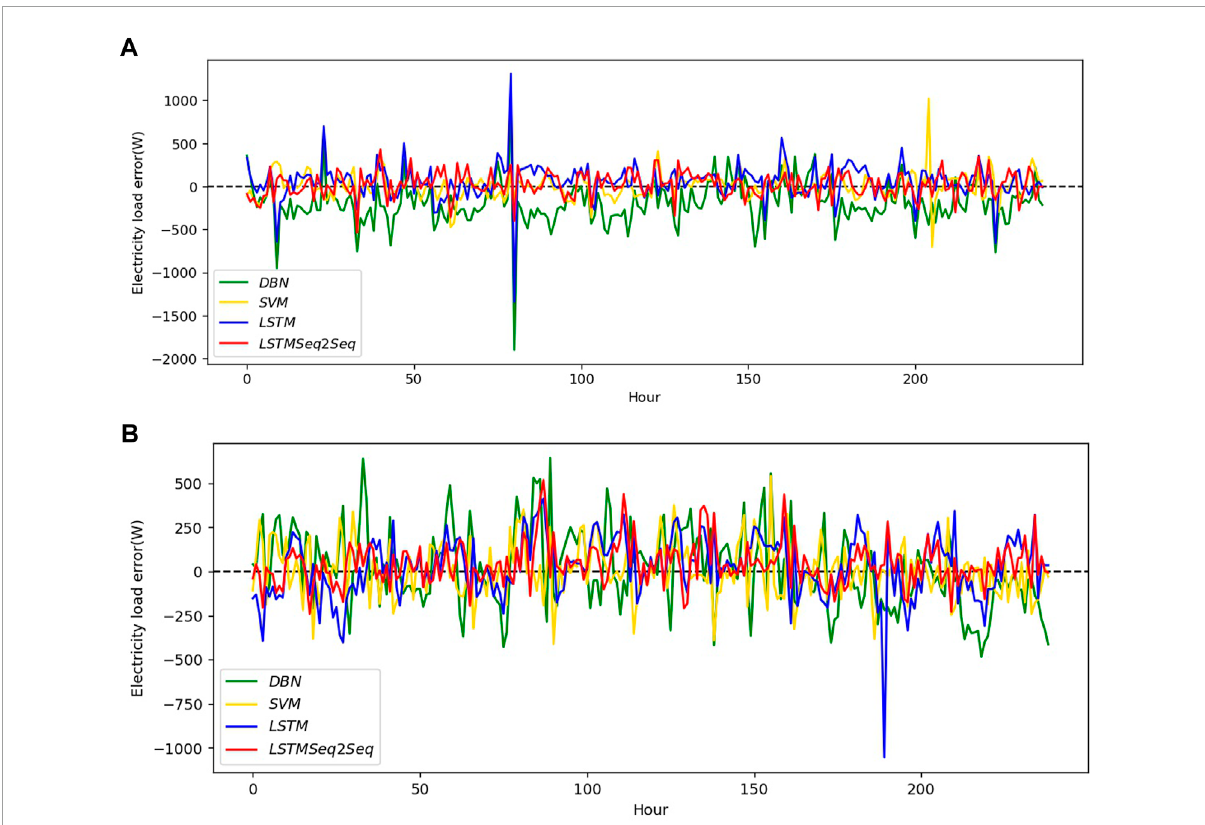
FIGURE 11 Error curves with different models with the two datasets. (A) Error curves with different models with dataset 1. (B) Error curves with different models with dataset